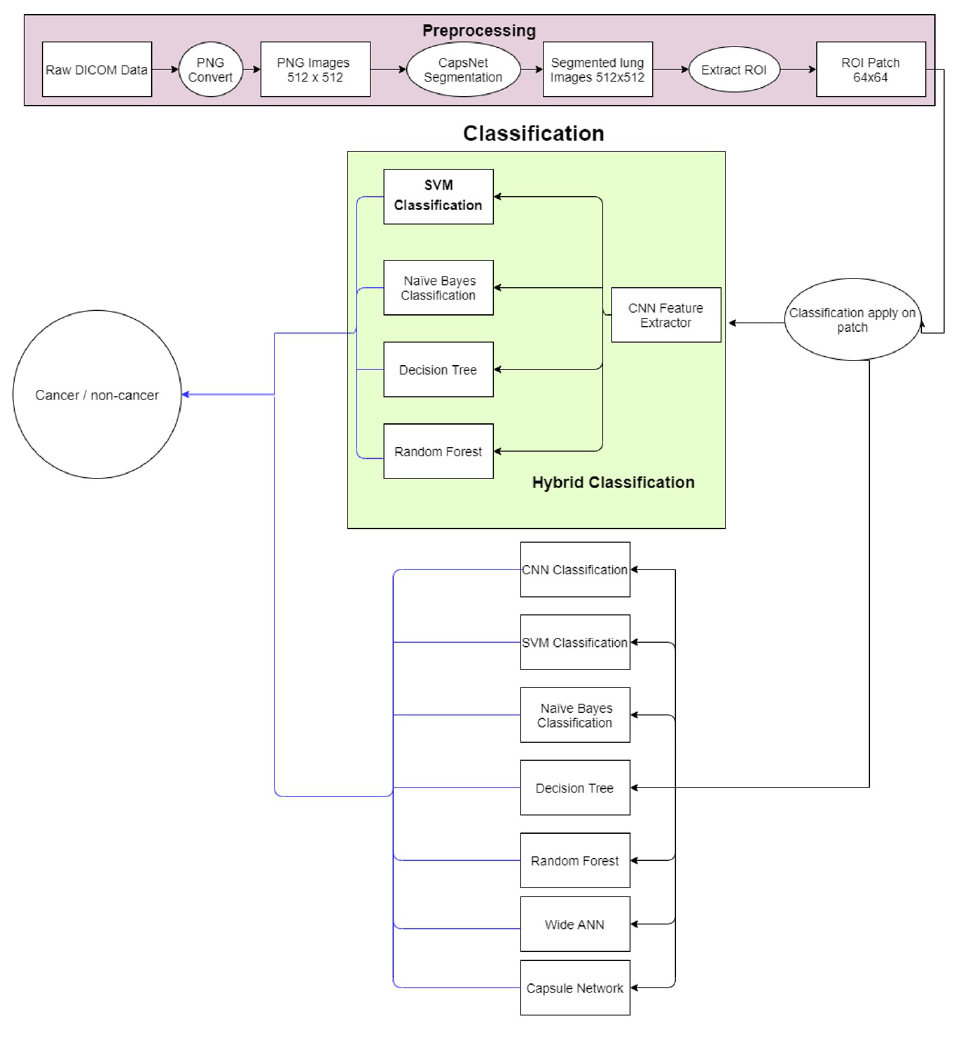
Figure 3. Flow diagram of the proposed